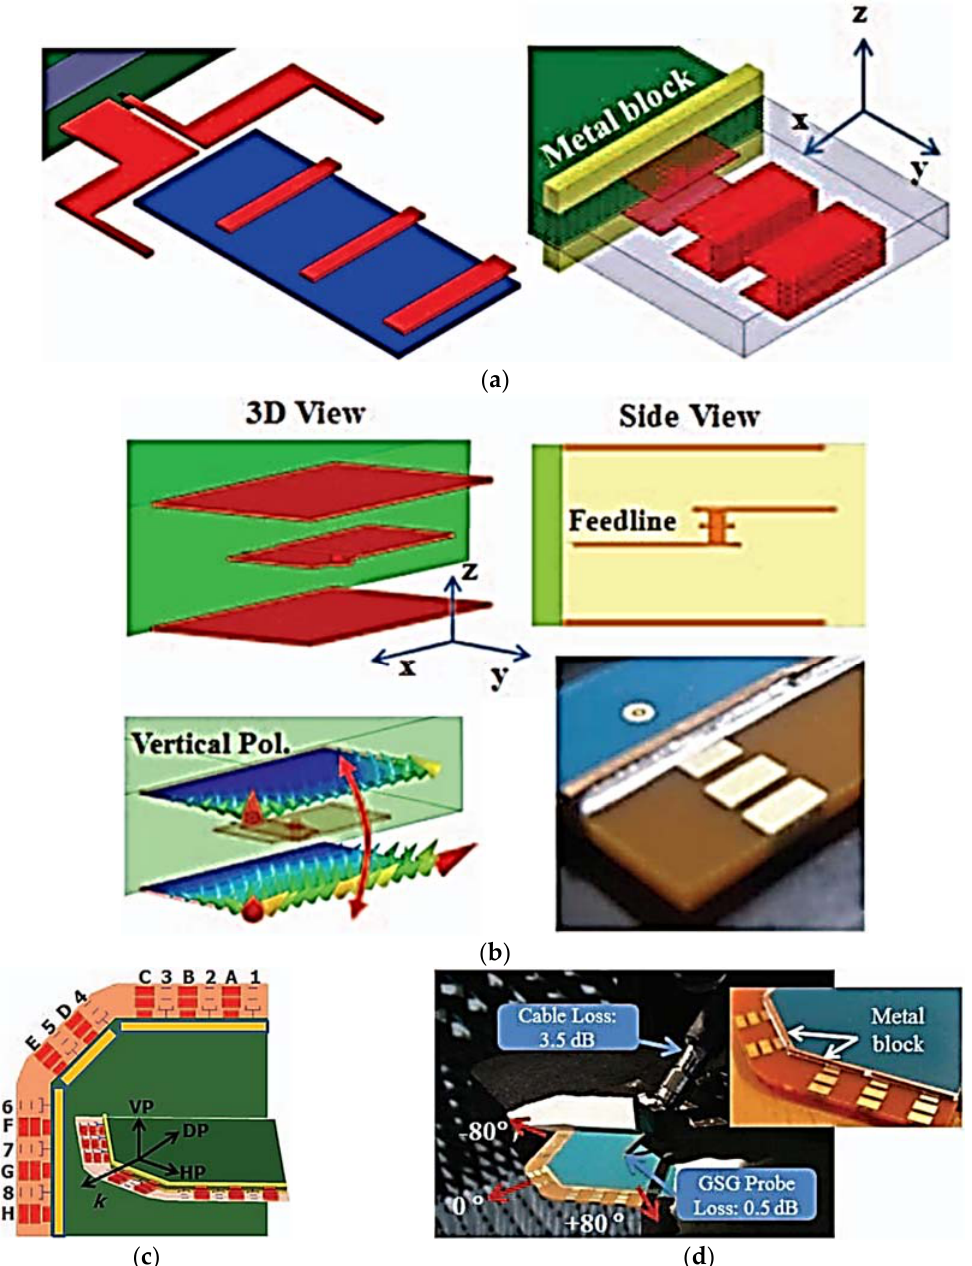
Figure 7. ( a ) Two discrete 28 ‐ GHz mm ‐ wave antenna elements, i.e., the horizontally polarized planar Yagi ‐ Uda antenna (left), and the vertically polarized multi ‐ plate antenna (right). ( b ) Final topology of vertically polarized multi ‐ plate antenna. ( c ) 16 ‐ element phased ‐ array configuration at the edge of the mobile terminal. ( d ) Photograph of the prototype testing in an anechoic chamber and close ‐ up view of 5G mm ‐ wave phased ‐ array antenna (Redrawn from [46]).